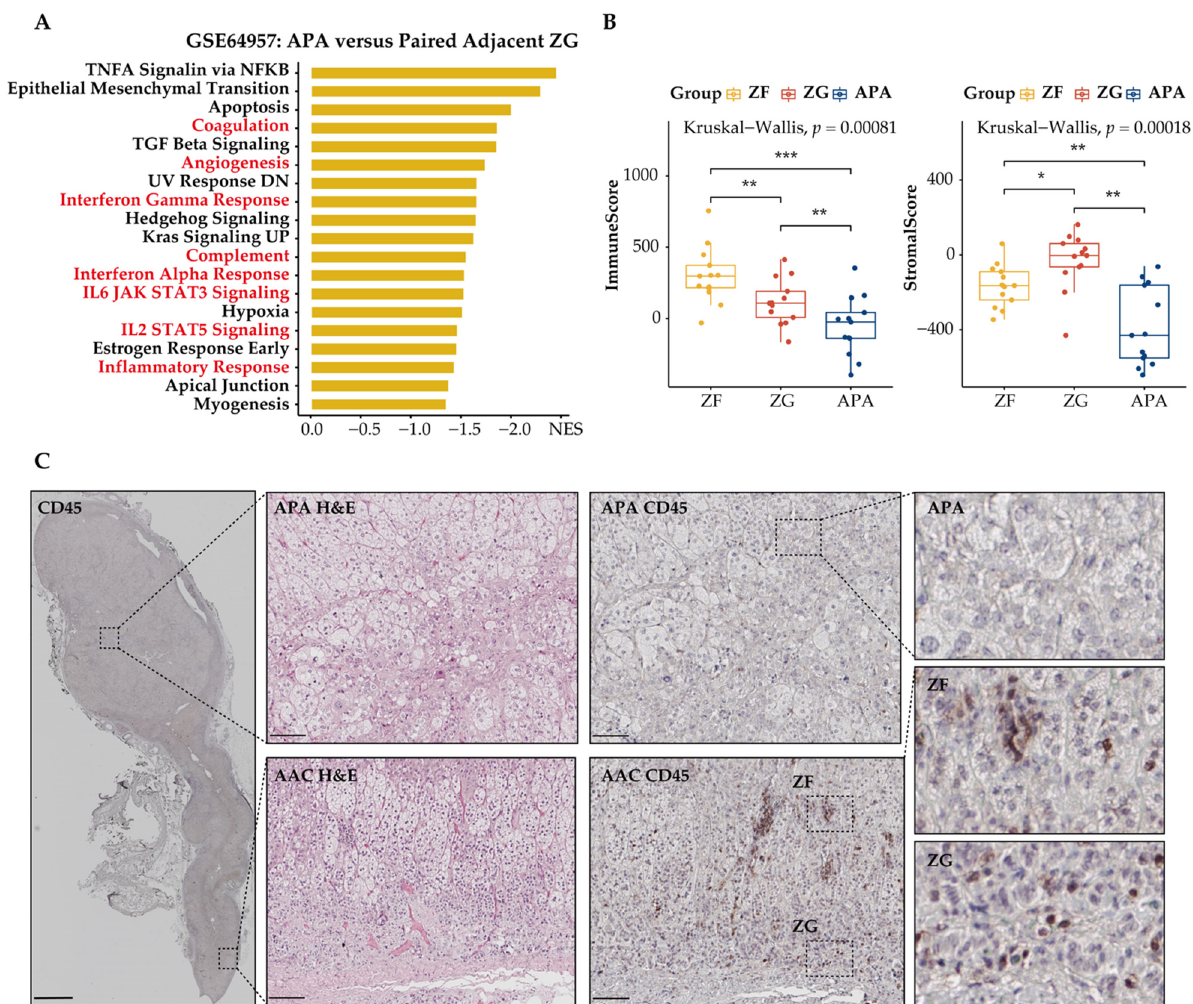
Figure 5. Spatial organization of tumor-infiltrating immune cells in APAs. Tumor-infiltrating immune cells in APAs were determined versus adjacent zona glomerulosa (ZG), and adjacent zona fasciculata (ZF). ( A ) GSEA showing MSigDB hallmark of downregulated differentially expressed genes in APAs versus adjacent ZG (GSE64957). Pathways in red indicate functions related to immune response. ( B ) ESTIMATE algorithm showing the distribution of ImmuneScore, StromalScore among APAs, adjacent ZG, and adjacent ZF. * p < 0.05, ** p < 0.01, *** p < 0.001 by paired Wilcox test. Kruskal–Wallis test was used between groups. ( C ) Immunohistochemistry of H&E and CD45 staining among APA, adjacent ZF, and adjacent ZG. Overview of CD45 image: scale bar 2 mm. Deep zoom images: scare bar 100 µ m. APA, aldosterone-producing adenoma; ACC, adjacent adrenal cortex; GSEA, gene set enrichment analysis; NES, normalized enrichment score; ZG, zona glomerulosa; ZF, zona fasciculata.